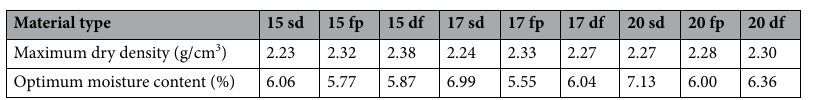
Table 1. Maximum dry density and optimum moisture content of lime and fly ash-stabilized macadam.